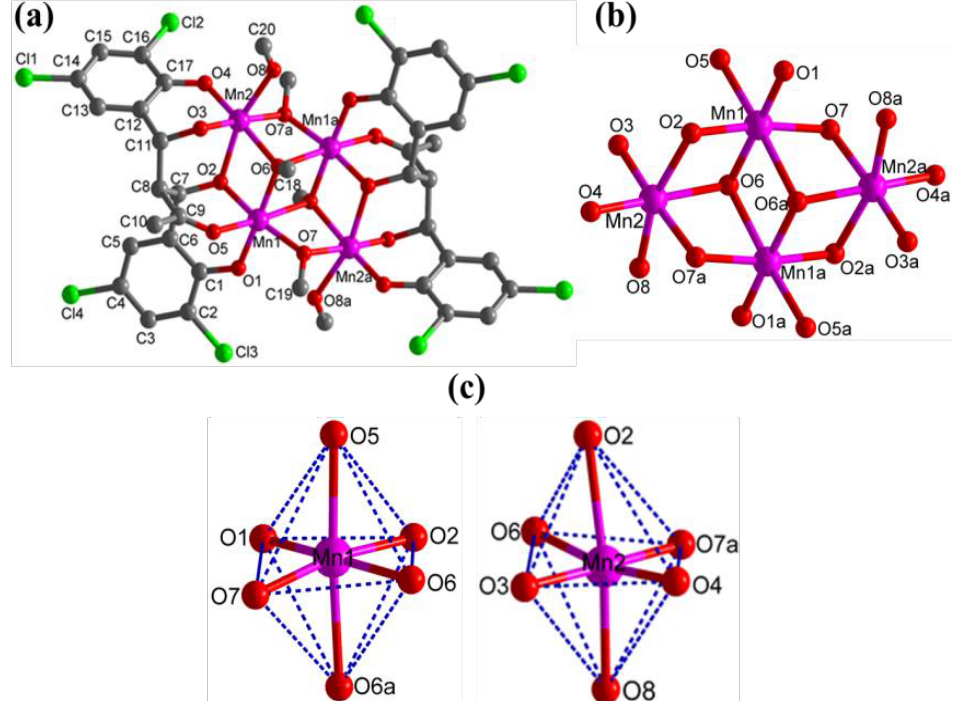
Figure 2. ( a ) Molecule structure and atom numbering of complex 1 (hydrogen atoms are omitted for clarity); ( b ) the planar Mn 4 rhombus and ( c ) the coordination polyhedra for Mn III atoms of complex 1 (symmetry code: a = 1 − x, 1 − y, 1 − z).